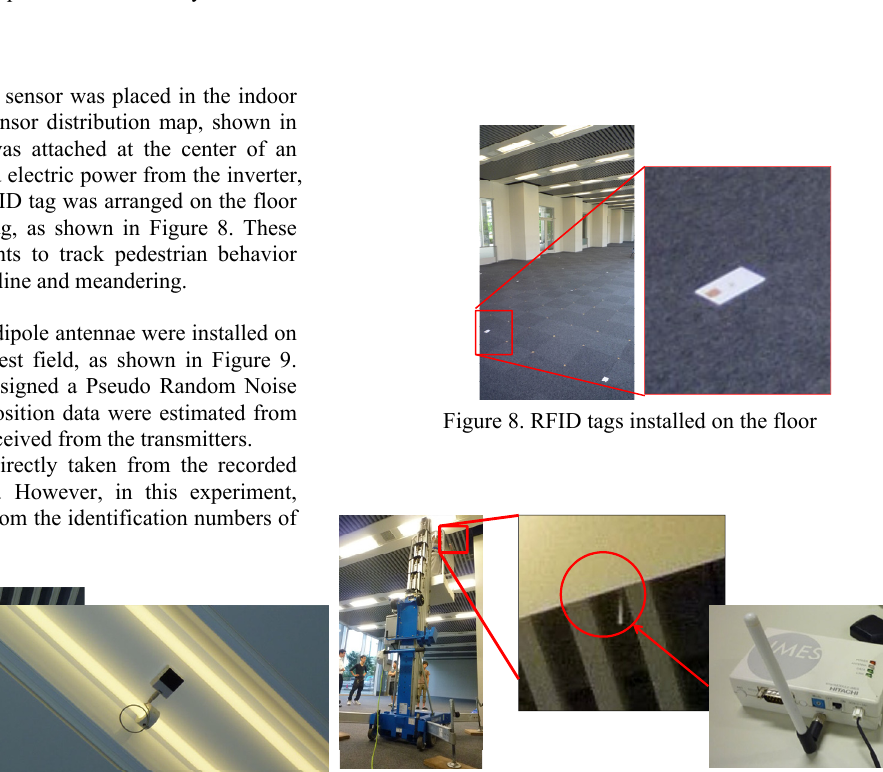
Figure 6. Sensor distribution map for the indoor study area